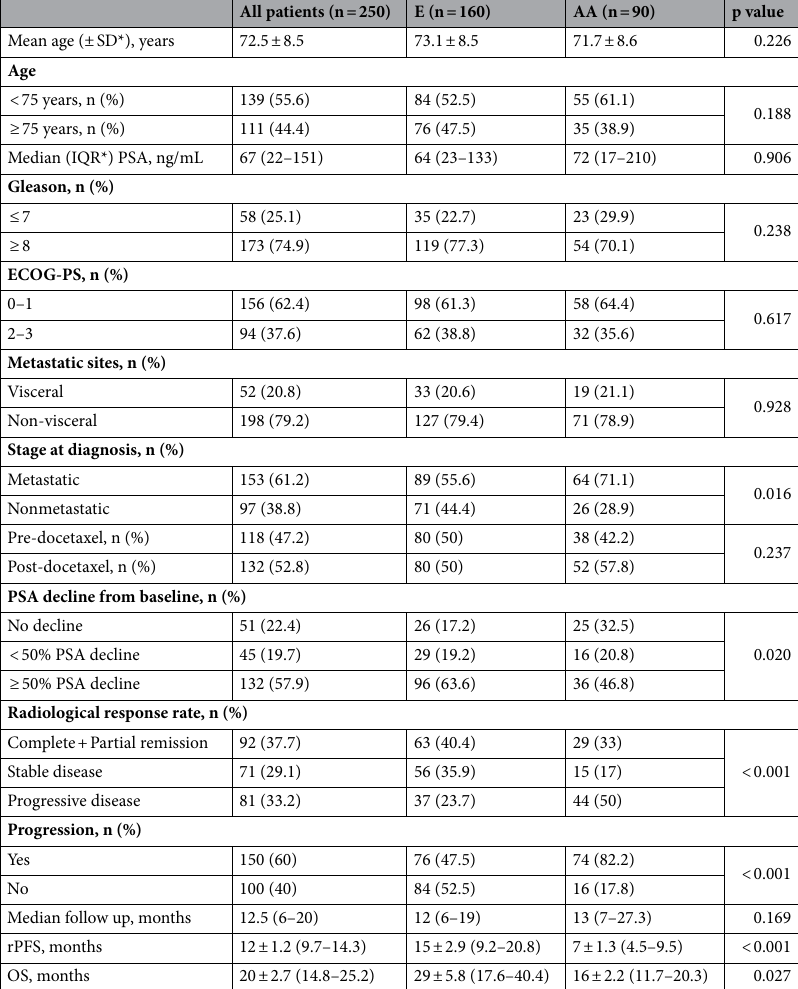
Table 1. Baseline patient characteristics and comparison between the drug groups. E enzalutamide, AA abiraterone acetate, PSA total prostate-specific antigen, ECOG-PS Eastern Cooperative Oncology Group- Performance Status, SD standard deviation IQR interquartile range, rPFS radiological progression free survival, OS overall survival. *Descriptive results for continuous variables are expressed as mean and standard deviation or as median and interquartile range, depending on the normality of their